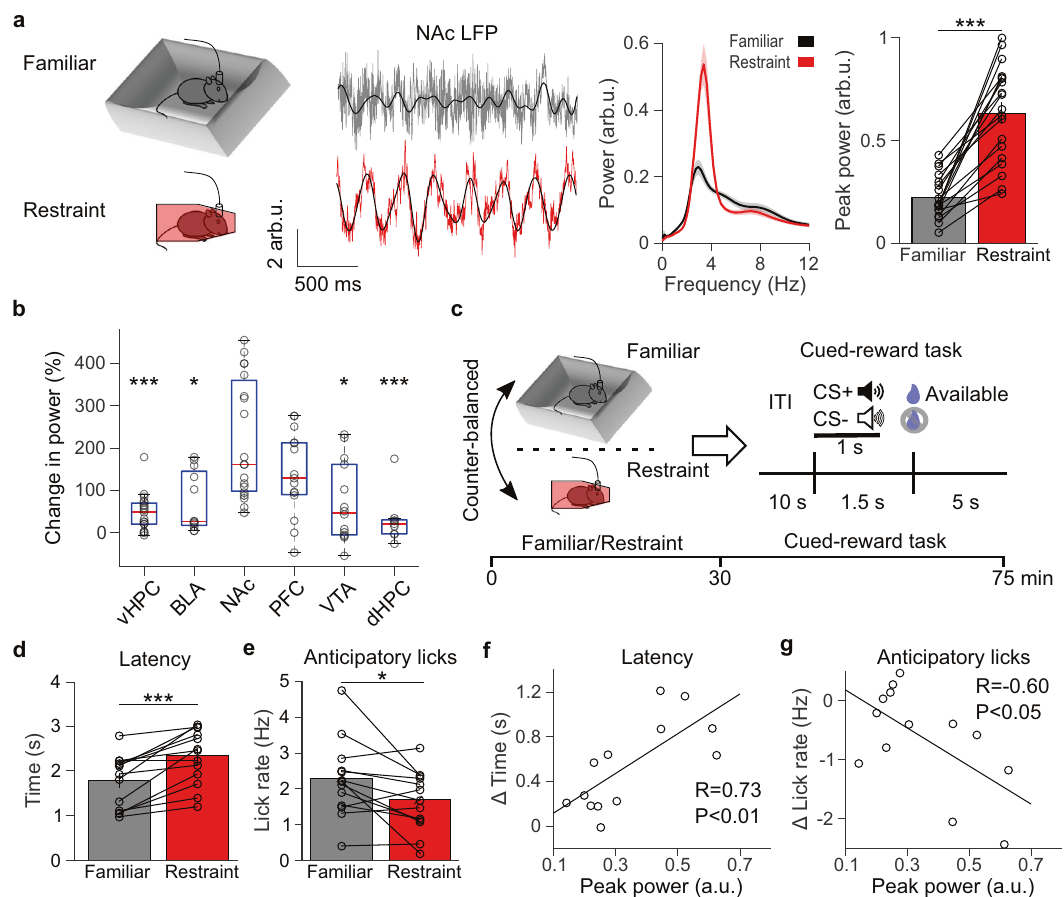
Fig. 1 Restraint stress re-organizes the NAc LFP and impairs subsequent reward-seeking. a Far left: experimental design. Left: representative traces of the nucleus accumbens (NAc) local fi eld potential (LFP) of a mouse freely exploring a familiar environment (gray) or during restraint (red), overlaid with the 2 – 7 Hz fi ltered signal (black). Voltage is normalized to the root mean square of a baseline recording and reported in arbitrary units (arb.u.). Right: average NAc LFP power spectra of mice exploring a familiar environment (black) or during restraint stress (red). Far right: restraint increases peak NAc power in the 4 (2 – 7) Hz range (*** P = 0.00013 two-tailed signed-rank test, n = 19 mice). Data are mean ± s.e.m. b The percent change in peak 4 Hz power from familiar to restraint was larger in the NAc than the ventral hippocampus (vHPC), basolateral amygdala (BLA), VTA, and dorsal hippocampus (dHPC) ( P < 0.0001 Kruskal – Wallis test; post hoc Tukey – Kramer comparisons *** P vHPC < 0.0001, n vHPC = 19 mice, * P BLA = 0.014, n BLA = 12 mice, P PFC = 0.20, n PFC